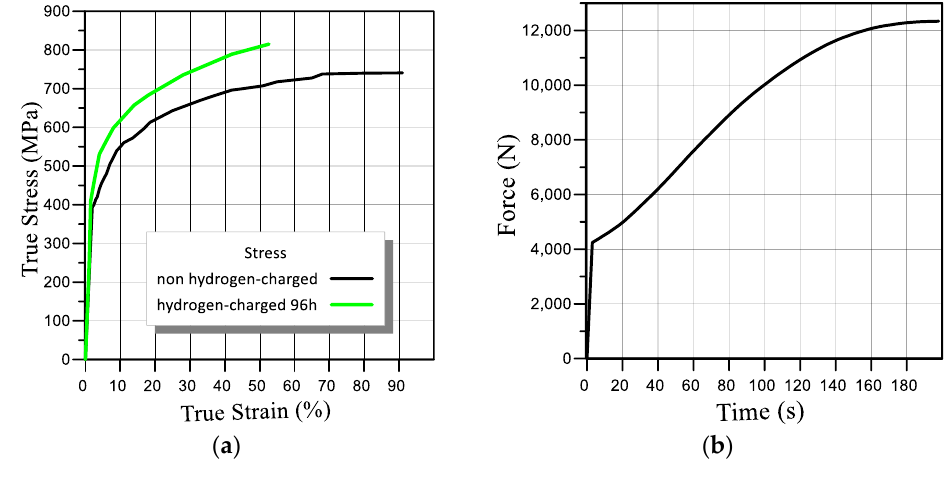
Figure 3. Stress –strain curves of steel 22К ( а ) and applied load ( b ) .